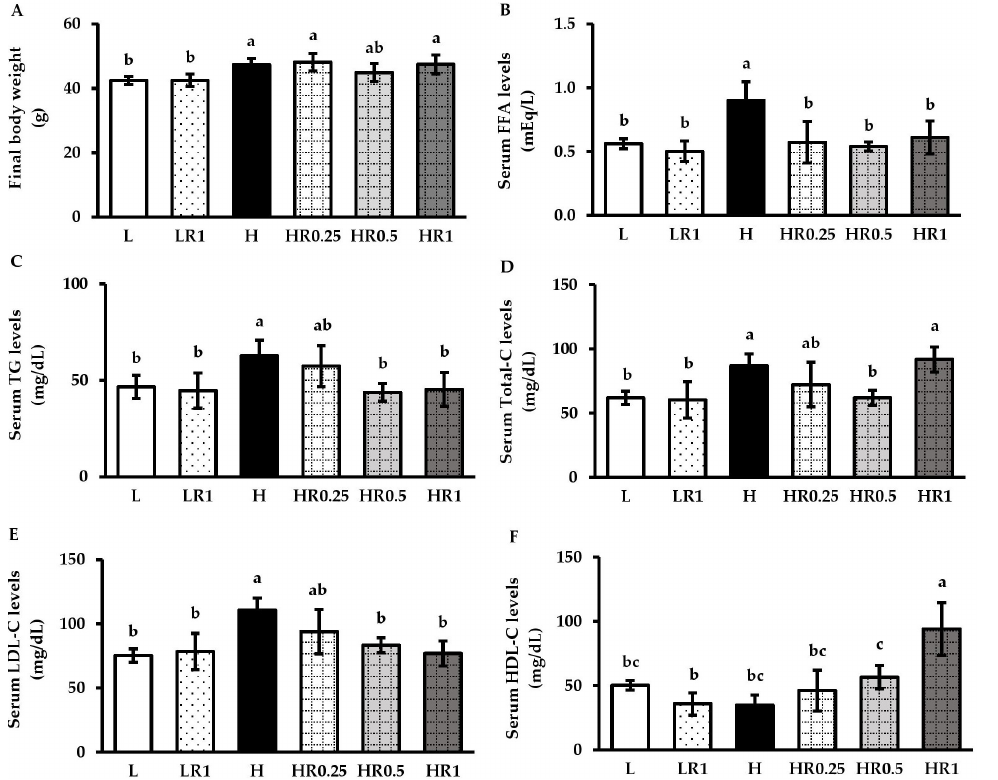
Figure 1. Effects of RRBE on obesity and dyslipidemia in mice fed with experimental diets: ( A ) final body weight; ( B ) serum FFA levels; ( C ) serum TG levels; ( D ) serum total-C levels; ( E ) serum LDL-C levels; ( F ) serum HDL-C levels. Values are means ± SD; 6 mice/group. Statistically significant difference at p < 0.05 was analyzed using one-way ANOVA with Tukey’s test and is indicated by different letters above error bars. The L, LFD, and distilled water co-treated group; LR1, LFD, and high-dose (1 g/kg) RRBE co-treated group; H, HFD, and distilled water co-treated group; HR0.25, HFD, and low-dose (0.25 g/kg) RRBE co-treated group; HR0.5, HFD, and middle-dose (0.5 g/kg) RRBE co-treated group; HR1, HFD, and high-dose RRBE co-treated